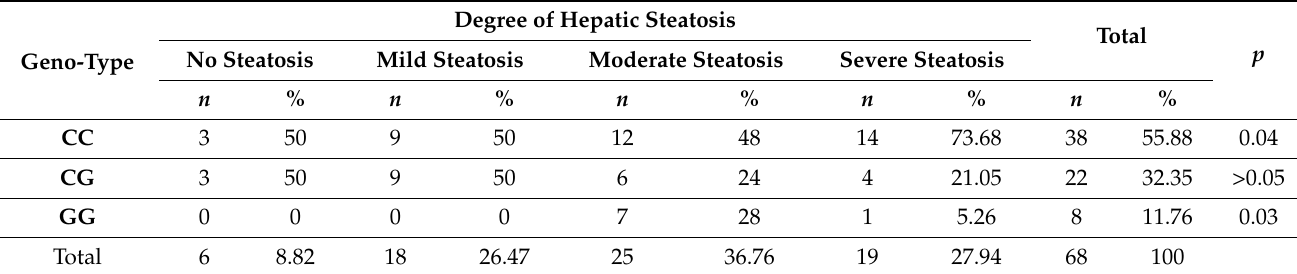
Table 5. Genotype frequency in subjects with different stages of hepatic steatosis.